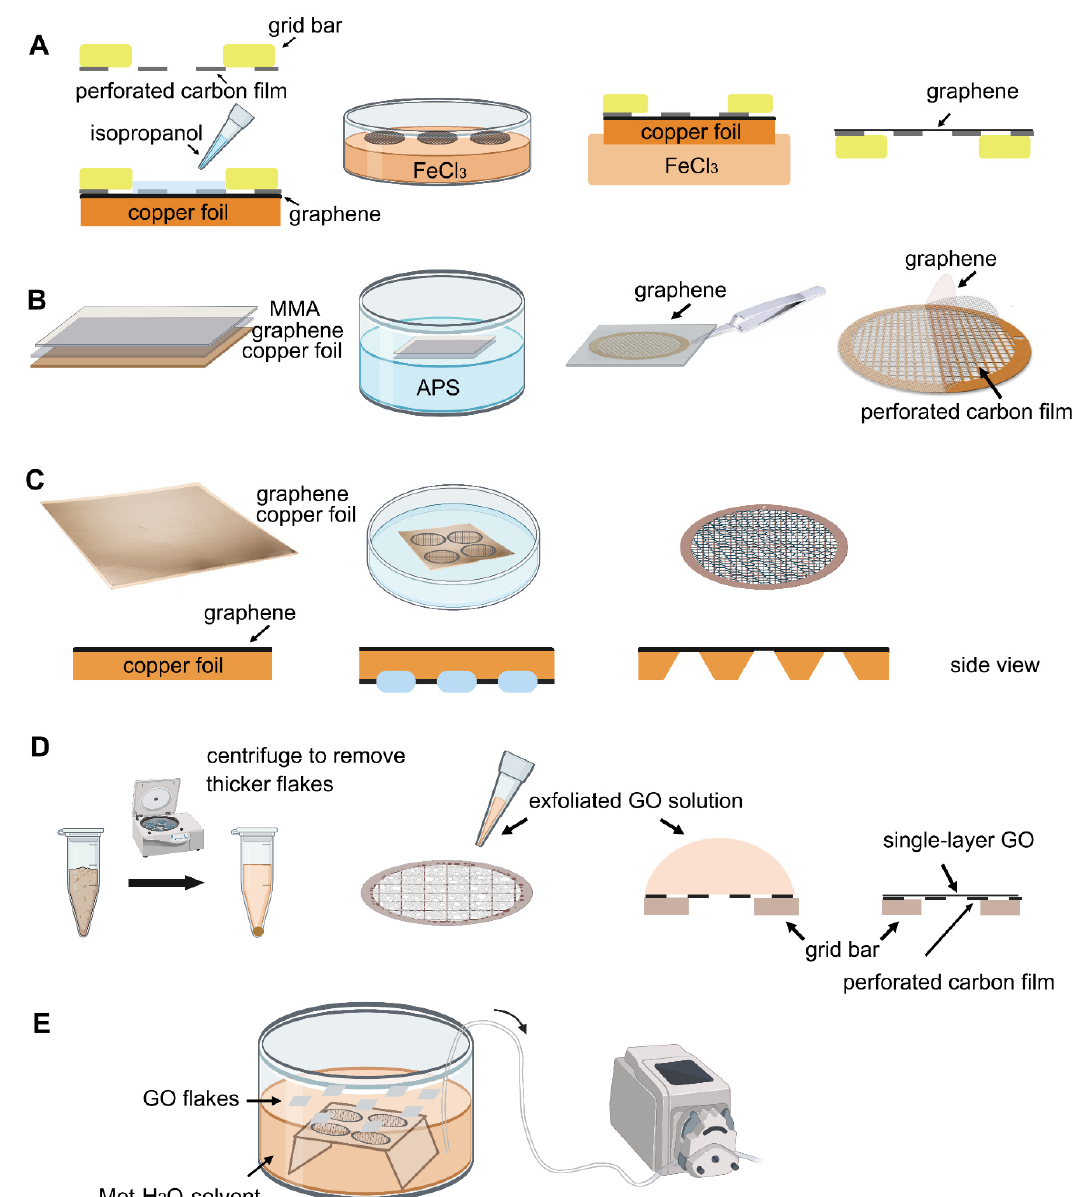
Figure 2. Schematic representation of different graphene grid ( A – C ) and graphene oxide grid ( D , E ) fabrication methods in primary steps. ( A ) The method uses isopropanol for adhering perforated carbon film with graphene by solvent wetting and then floats the grid-graphene-copper sandwich in FeCl 3 to etch away the copper substrate [34]. ( B ) The method uses MMA to transfer graphene to the APS solution. After transferring graphene to the EM grid, the MMA film can be digested [58]. ( C ) The method directly etches the backside of copper foil that supports graphene growth into arrayed Cu grids by direct photolithography in batch fabrication [59]. ( D ) The method centrifuges the GO flakes to make them more homogeneous, then apply a droplet of GO solution to the perforated carbon film. After waiting for the interaction between GO flakes and the holey carbon, blot away the excess solution and let the GO-covered grid dry for use [26]. ( E ) Use methanol-water (Met-H 2 O) solvent to disperse GO flakes, embed the grids with perforated carbon film facing up, and slowly pump out the solution to let the GO flakes adhere to the submerged grids